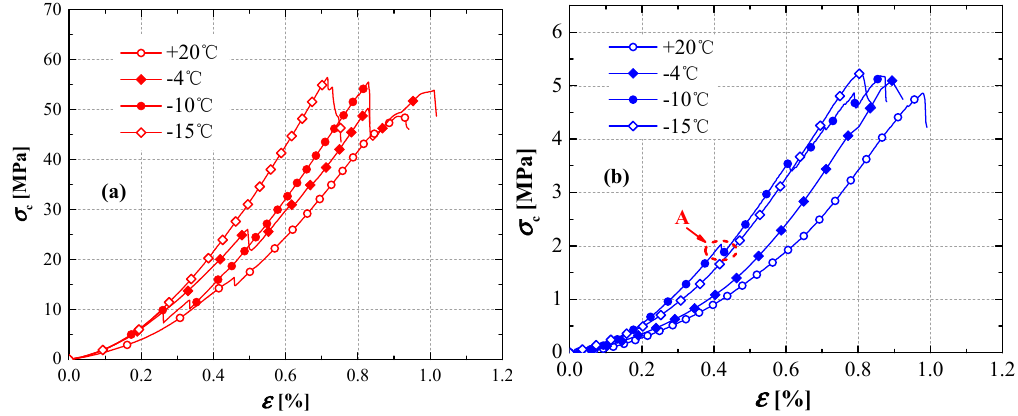
Figure 3. Stress–strain curves from uniaxial-compression tests: ( a ) sandstone; ( b ) coal samples.